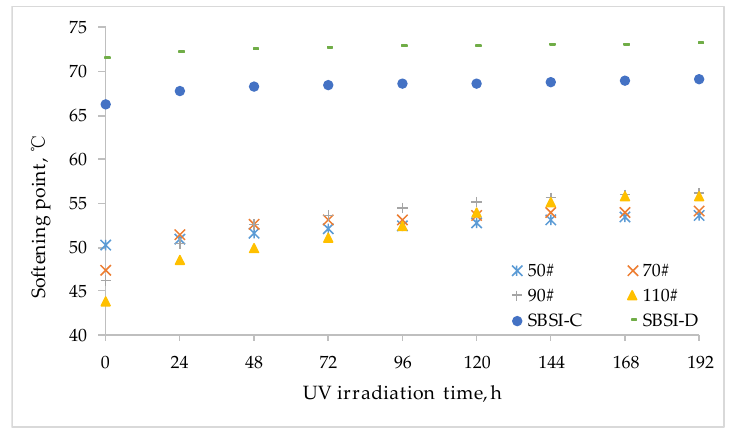
Figure 6. The softening point of asphalt with different UV irradiation time.